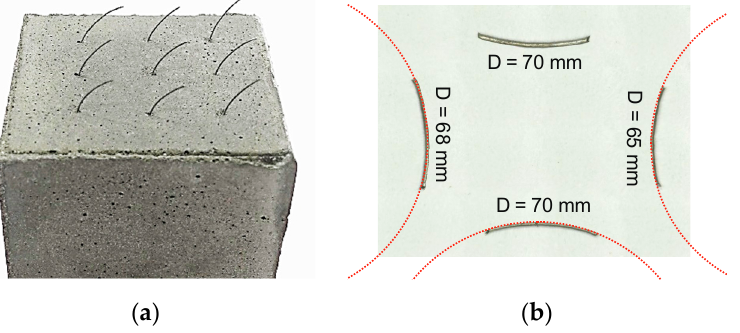
Figure 8. Determining the mandrel diameter: ( a ) bent fibres of specimen and ( b ) iteratively applied circles for measuring with digital microscopy.